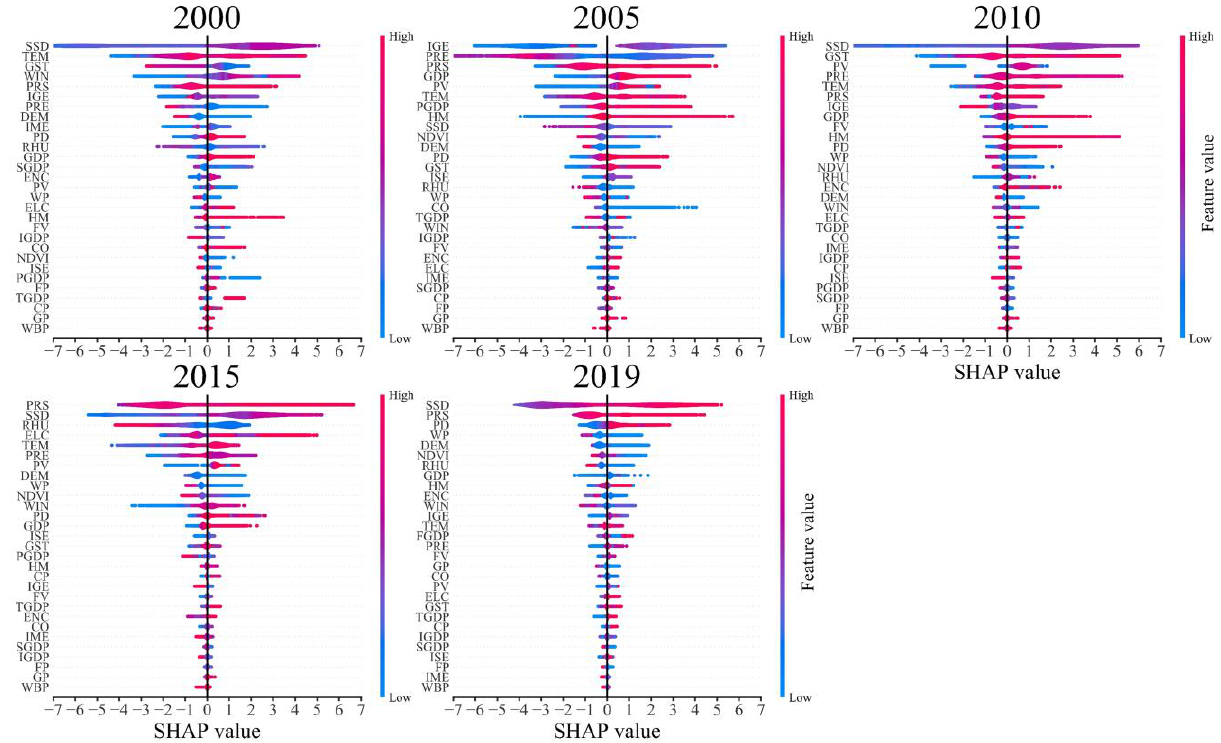
Figure 6. The positive and negative impact of SHAP values in five selected years. Negative SHAP value means that the influencing factor at this location has a negative impact on PM 2.5 , and vice versa.